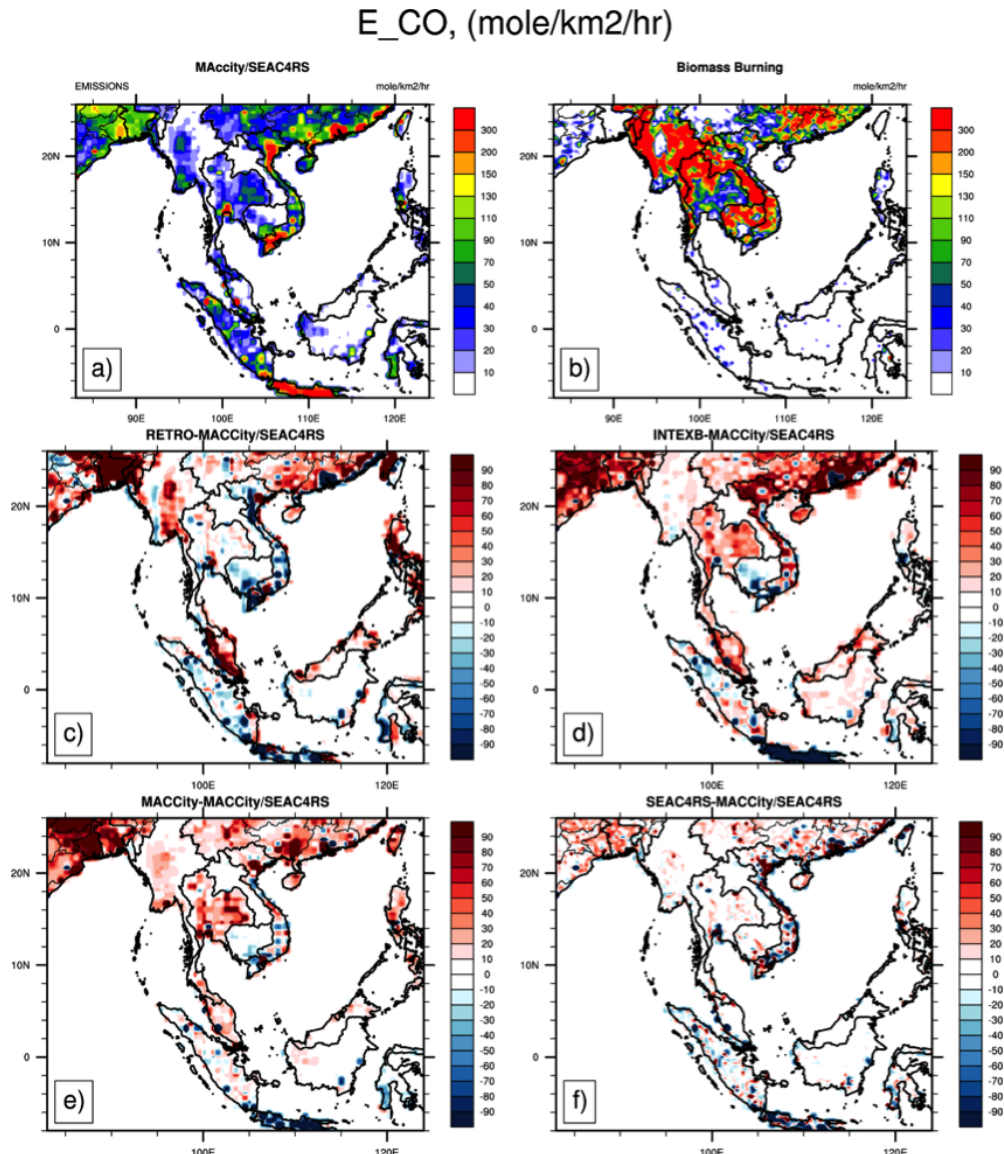
Figure 1. CO emissions for March 2008 from different emission inventories: (a) MACCity–SEAC4RS, (b) biomass burning, (c) RETRO - MACCity–SEAC4RS, (d) INTEX-B - MACCity–SEAC4RS, (e) MACCity - MACCity–SEAC4RS, and (f) SEAC4RS - MACCity–